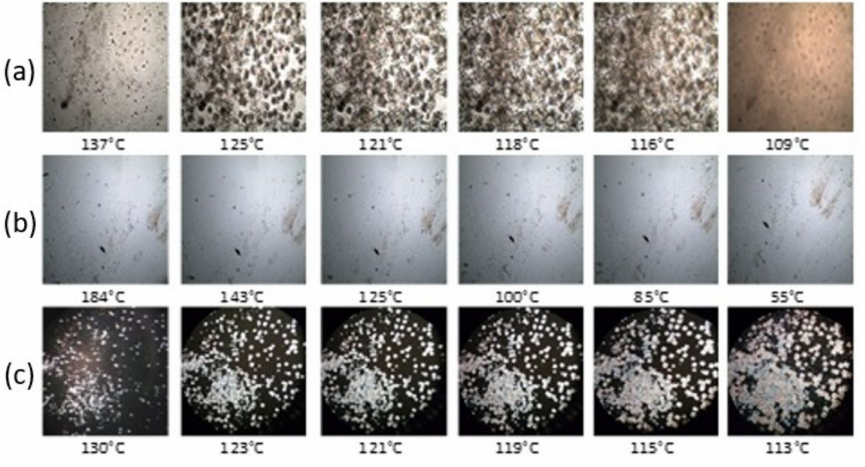
Figure 8. POM micrographs of (a) base-PLLA (P b ) ( a ), stereo-complexer PDLA(P m1 ) ( b ) and resulting stereo-complexed compound sc-1 ( c ), taken during non-isothermal crystallization.